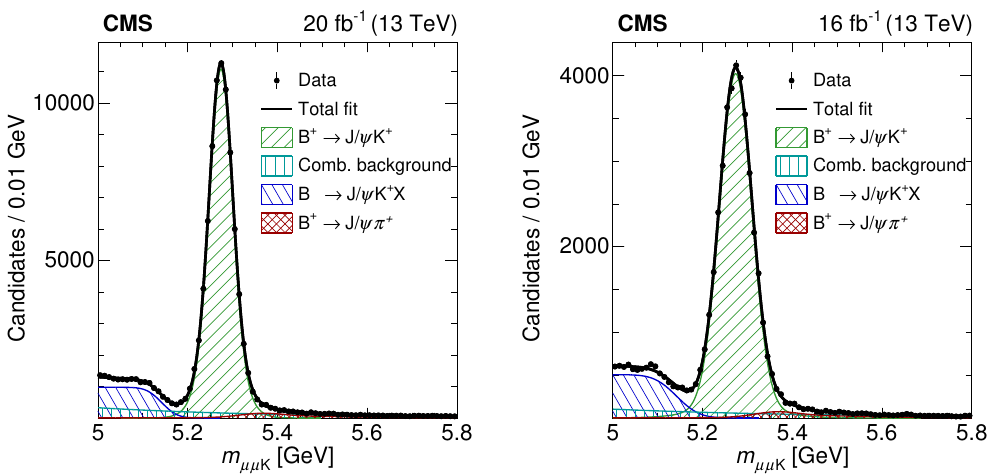
Figure 1 . Invariant mass distributions for the (cid:22)(cid:22) K system used to reconstruct the B + ! J = K + normalization sample. The plot on the left shows the 2016A central-region channel ( j (cid:17) f while the plot on the right shows the 2016B forward-region channel (0 : 7 < j (cid:17) f resolutions for these channels are 30 and 43 MeV, respectively. The data are shown by solid black circles, the result of the (cid:12)t is overlaid with the black line, and the di(cid:11)erent components are indicated by the hatched